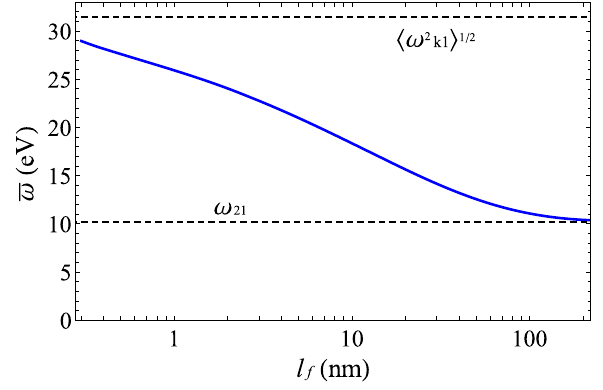
FIG. 1. Dependence of ¯ ω on the ensemble longitudinal dimen- sion l in hydrogen (here, to be short, ℏ ¼ 1 f